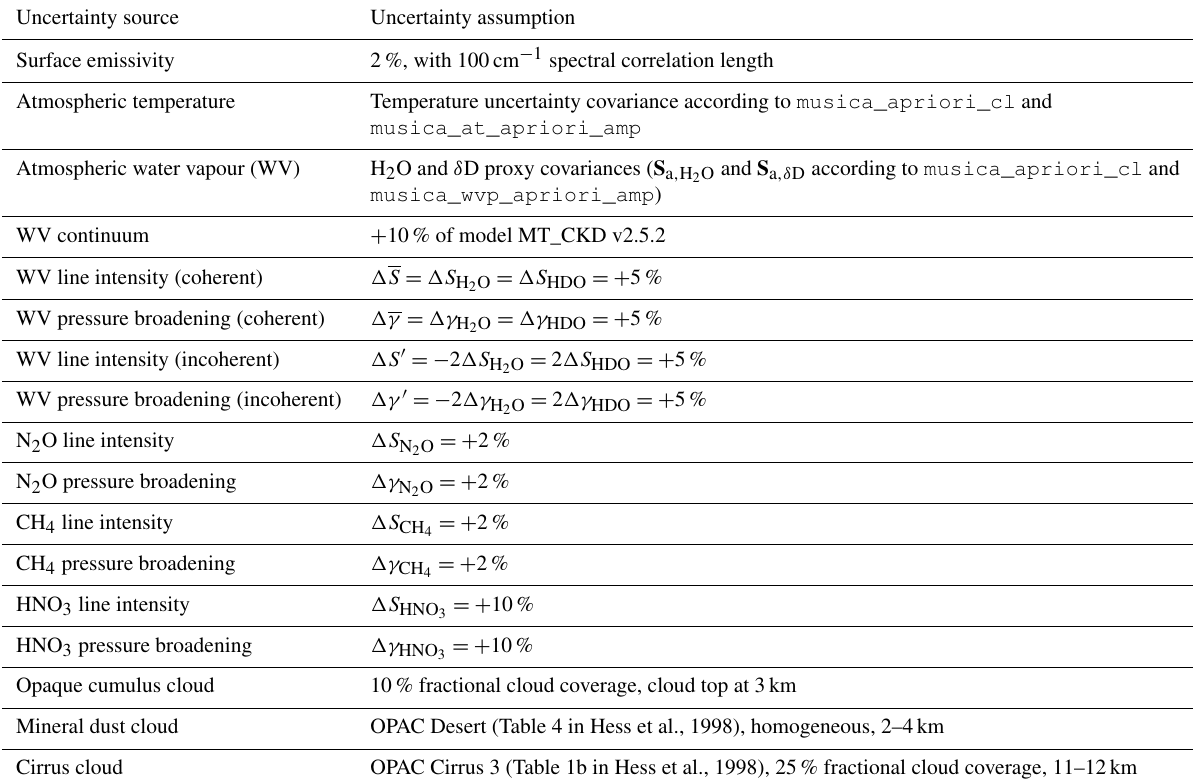
Table 3. List of uncertainty assumptions used for the error estimations as shown in Fig. 12. Uncertainty